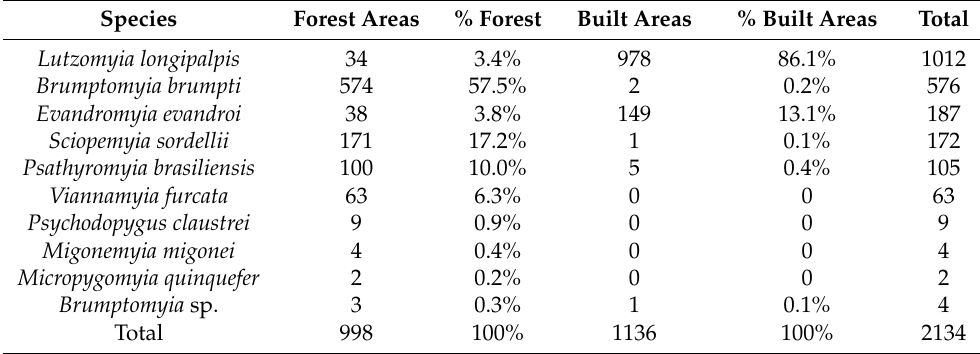
Table 2. Distribution of the sand flies captured in the forest areas and in the built areas in the city of Jo ã o Pessoa, state of Para í ba, Brazil. Species